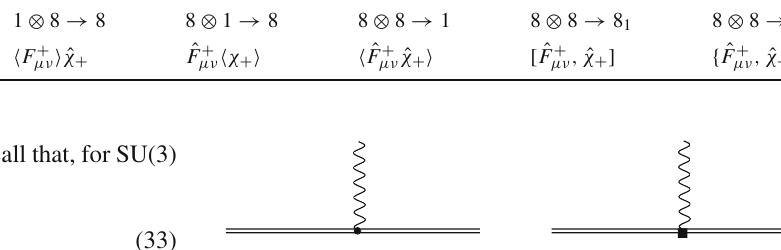
Fig. 1 The O ( p 2 ) and O ( p 4 ) tree level diagrams where the spin- 3 doubly charmed baryon is denoted by the double solid line. The solid dot and black square represent the second- and fourth-order couplings, respectively